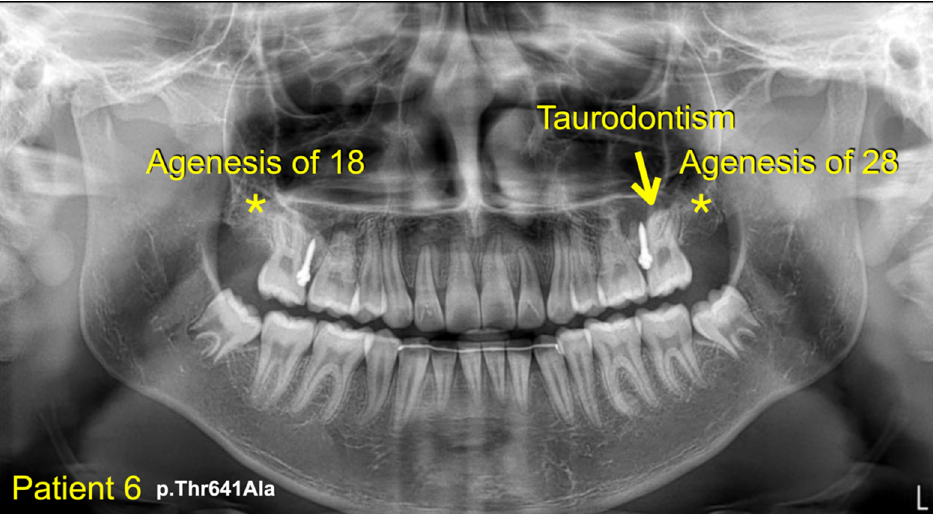
Figure 4. Patient 6. Panoramic radiograph showing agenesis of the maxillary permanent third molars (asterisks). Taurodontism of the left maxillary permanent second molar (arrow). The heterozygous missense variant c.1603C>T; p.Arg535Cys was identified in patient 1, who had a mesiodens and torus palatinus. According to gnomAD, this variant is rare, with a global allele frequency of 0.0001712. It has not been reported in the South Asian population. Its allele frequency in the East Asian population is 0.002164. According to the T-Rex database, this allele was found in 4 out of 2184 alleles (allele frequency = 0.0018315 or 0.18%). The allele frequency of this variant in the study group (0.409836%) is higher than those in the normal Thai population (T-Rex database) and in gnomAD (Table 2). This variant is predicted to be disease causing, possibly damaging, and damaging by MutationTaster (prob = 0.99999999580175), PolyPhen-2 (0.994), and SIFT (0.001), respectively. The CADD and DANN scores of this variant are 25.4 and 0.9992, respectively (Table